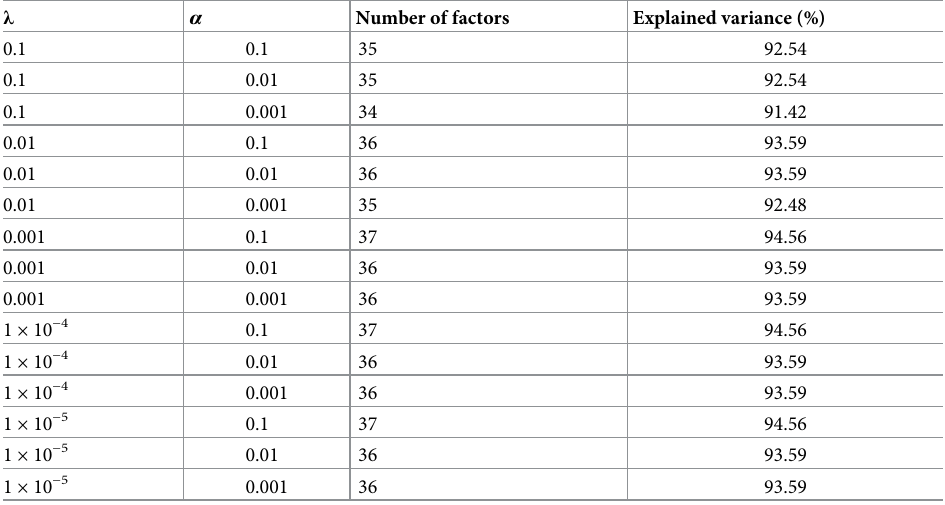
Table 7. Number of factors as a function of λ and α .